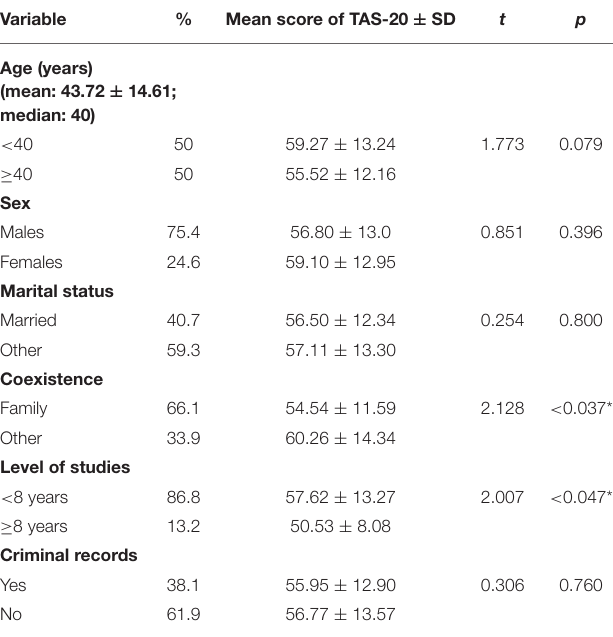
TABLE 1 | Sociodemographic variables related to alexithymia levels.